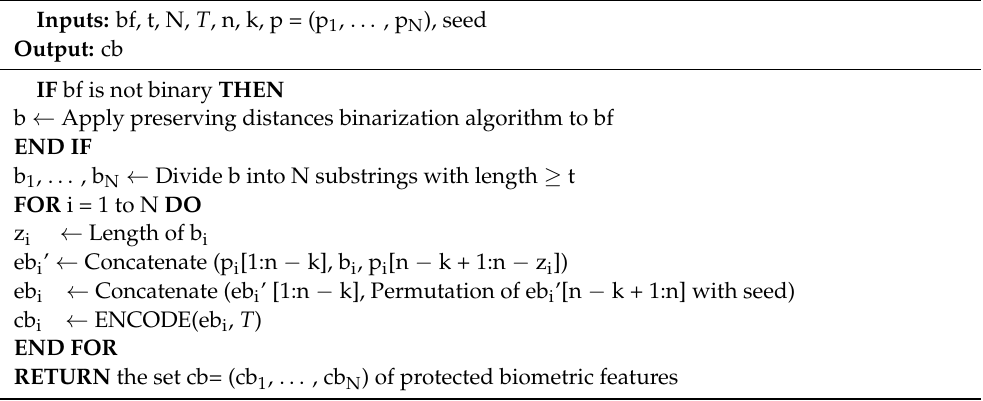
Figure 3. Biometric Feature Transformation: ( a ) at the enrollment phase and ( b ) at the verification phase. ( c ) shows the application of the XOR operation to the biometric features transformed in ( a ) and ( b ). Algorithm 1: Pseudocode to generate protected biometric features.